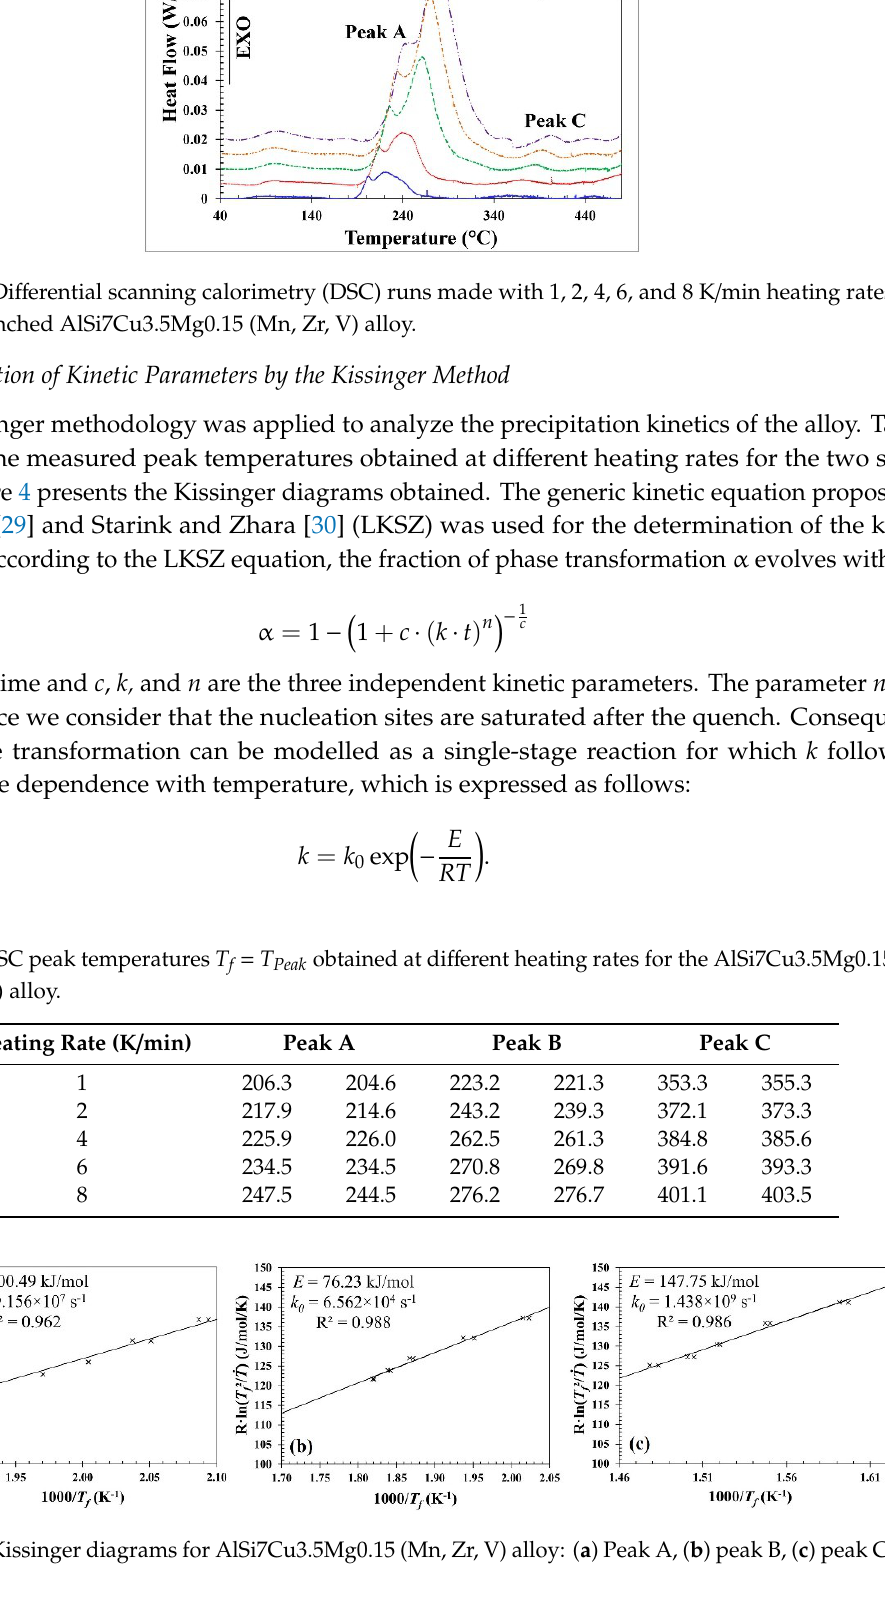
Figure 5. DSC run and peaks (A, B, C) adjusted to optimize the fit between experimental and sum of the heat produced by associated transformations for AlSi7Cu3.5Mg0.15 (Mn, Zr, V) alloy. Table 3. Parameters from the fitting procedure for AlSi7Cu3.5Mg0.15 (Mn, Zr, V) alloy. Peak